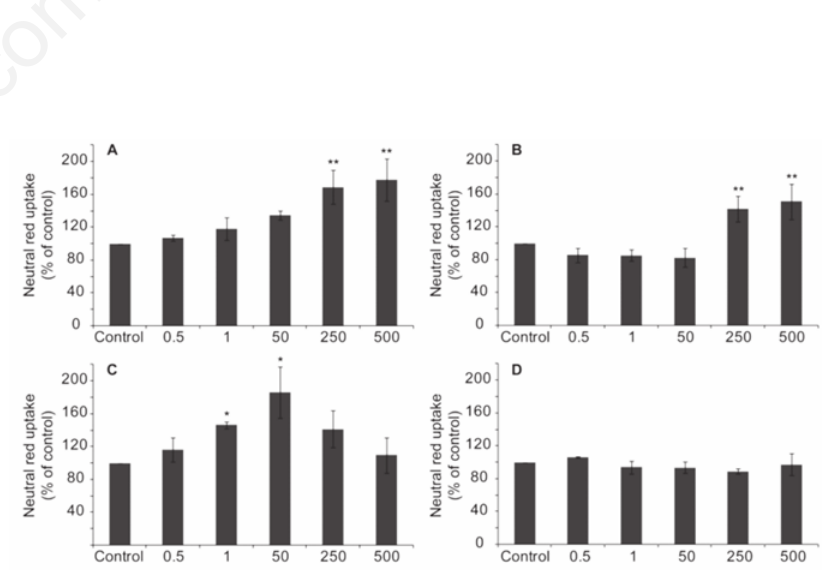
Figure 2. Results of neutral red uptake by control and exposed abalone hemocytes. NR uptake by cells exposed to different concentrations (µg/L) of venlafaxine (A), gabapen- tine (B), cetirizine (C) or acebutolol (D) were given compared to the 100% control. Each data point represents the mean percentage±S.D. of triplicate cultures. Significant differ- ences from control cells were indicated by stars: *P<0.05,